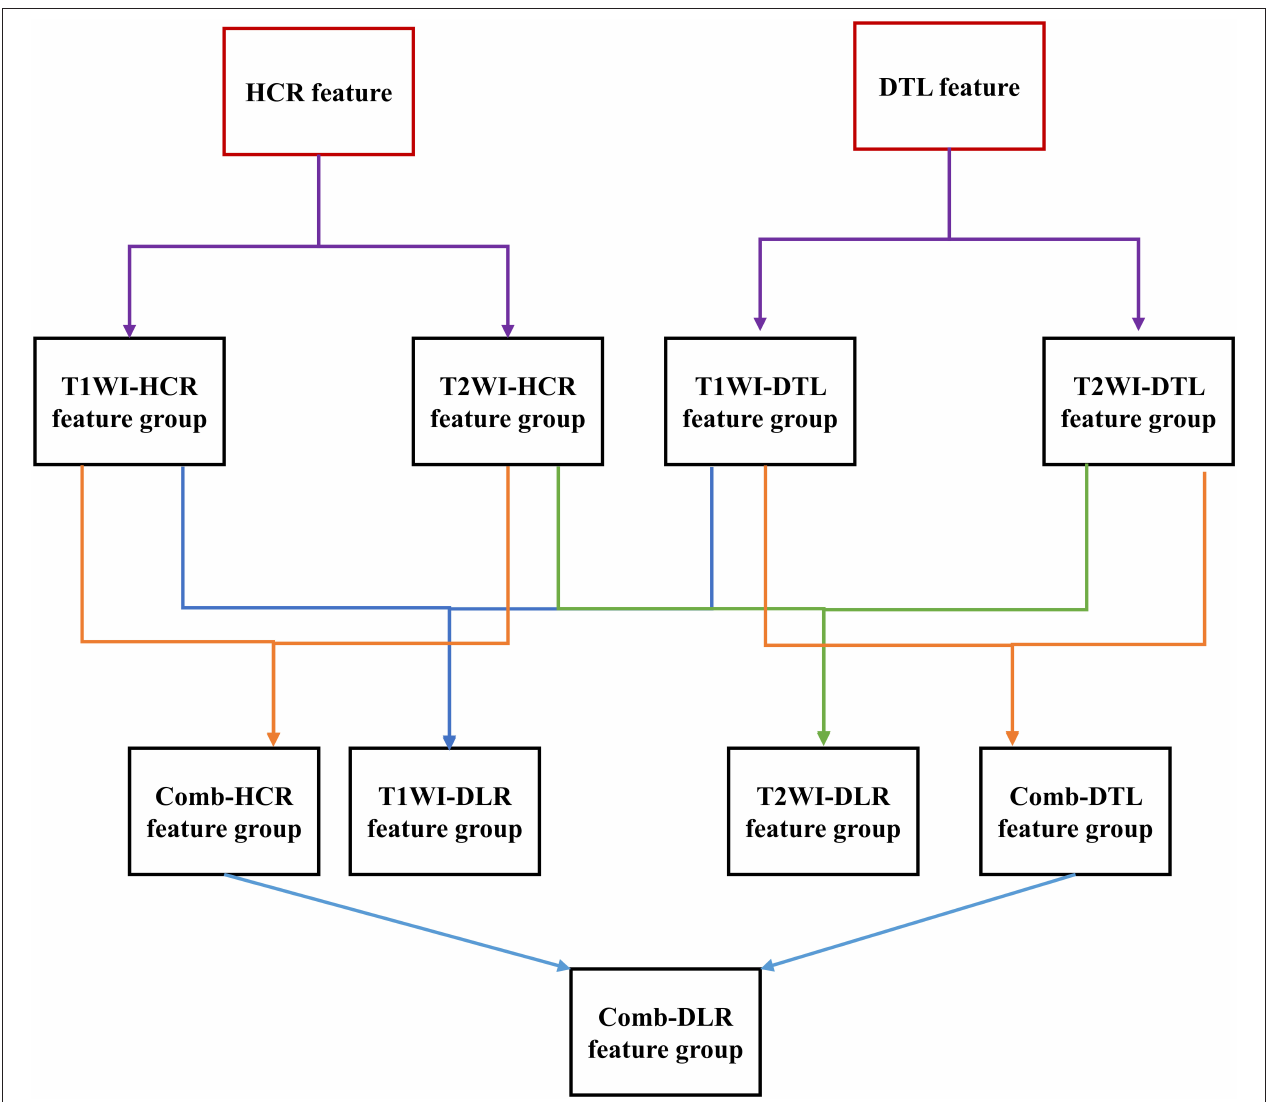
FIGURE 2 | Feature selection and fusion flow chart. The red box is the original extracted feature. The black box is the feature group. Each feature group contains 10 features. A new feature group was formed after feature fusion and screening of two feature